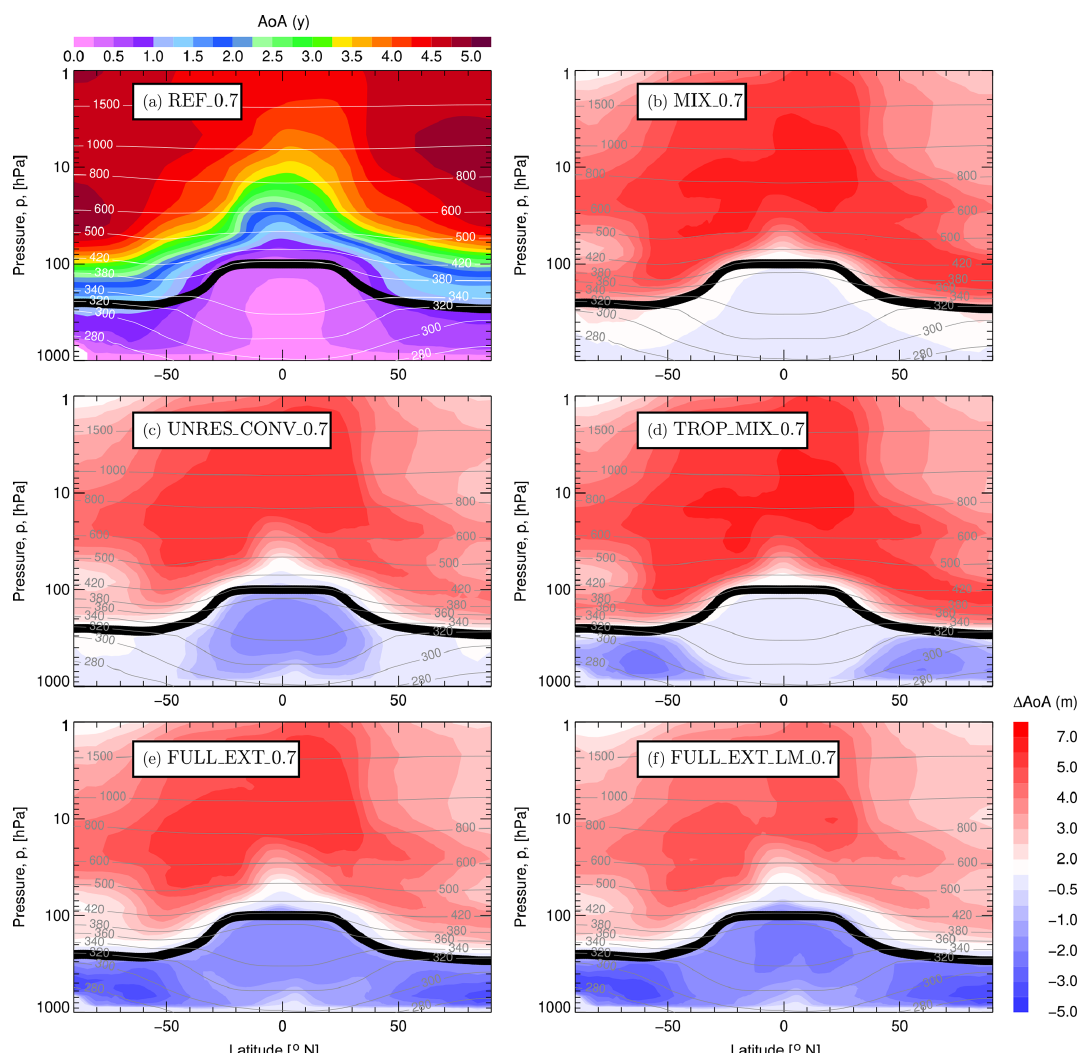
Figure 11. Annual and zonal mean of AoA (for 2007, in years) as derived from the reference simulation REF_0.7 (a) and the differences relative to this distributions (in month) calculated for some configurations listed in Table 1. Black line denotes the